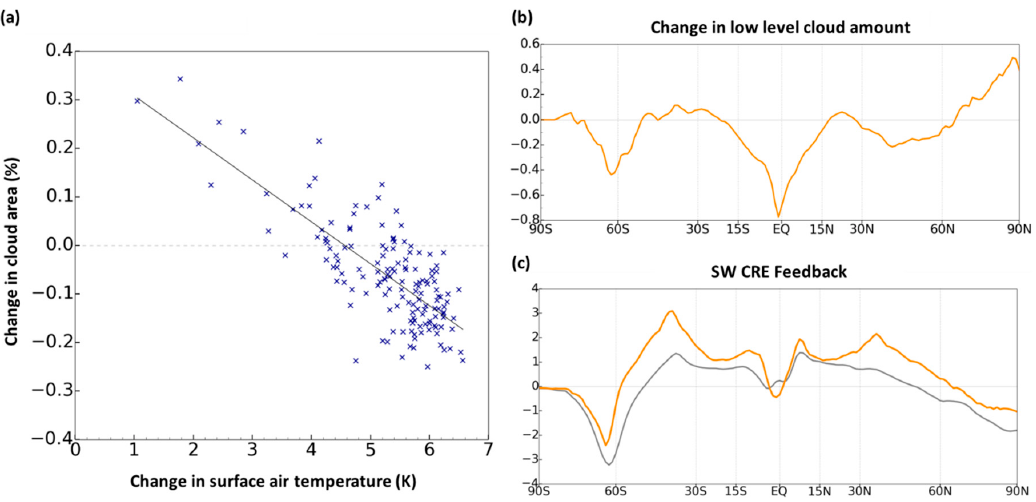
Figure 7. ( a ) Change in global mean low-level cloud area (%) as a function of global mean surface air temperature over 150 years in the abrupt experiments for K-ACE. Zonal mean ( b ) change in low-level cloud, and ( c ) λ SWCRE from K-ACE (orange line) and CMIP5 models (gray line).